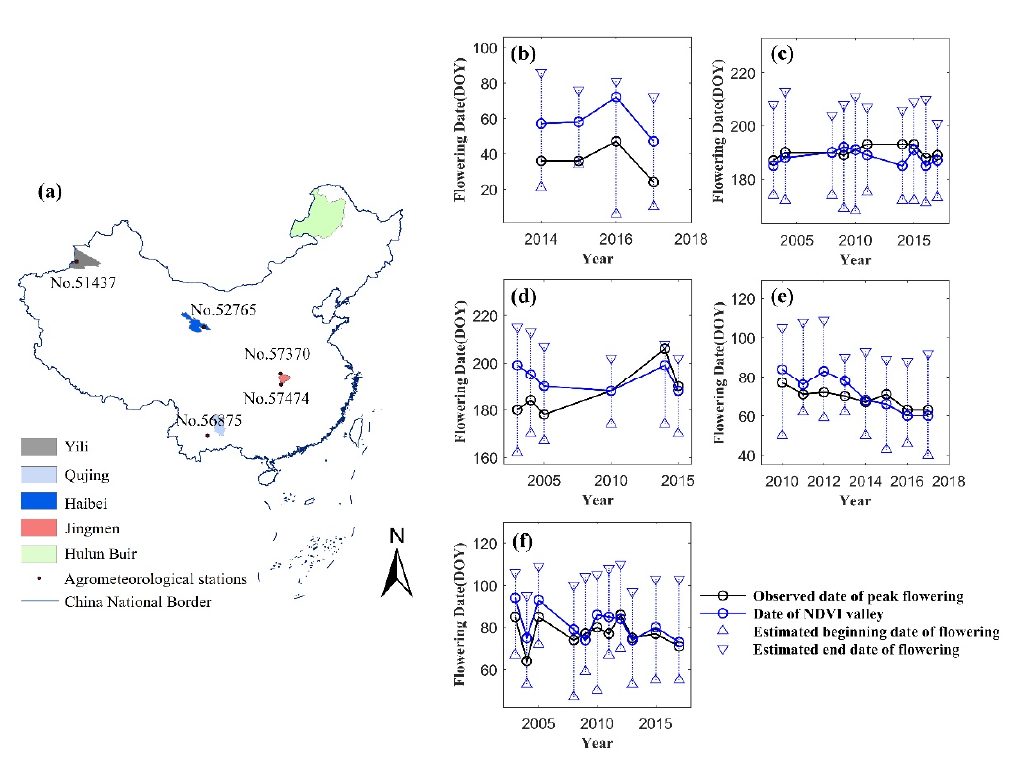
Figure 10. Comparison between flowering date obtained from agrometeorological stations and flowering date estimated from empirical regression model and NDVI time-series at five agrometeorological stations. ( a ) The distribution of five stations. ( b ) No.56875 station, ( c ) No.52765 station, ( d ) No.51437 station, ( e ) No. 57474 station, ( f ) No.57370 station.